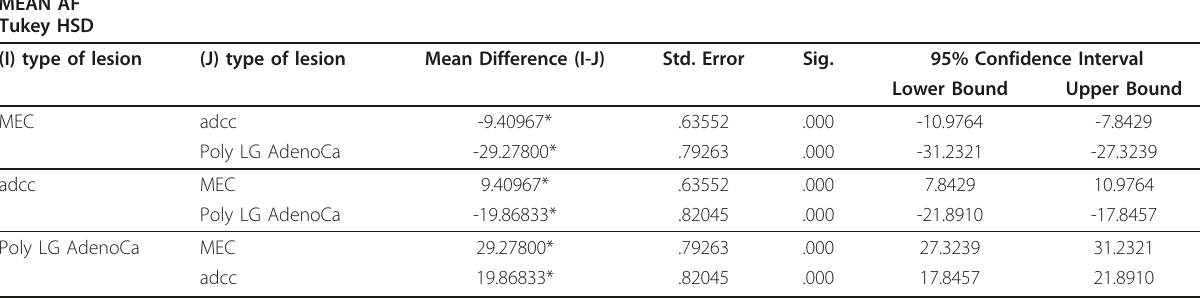
Multiple Comparisons